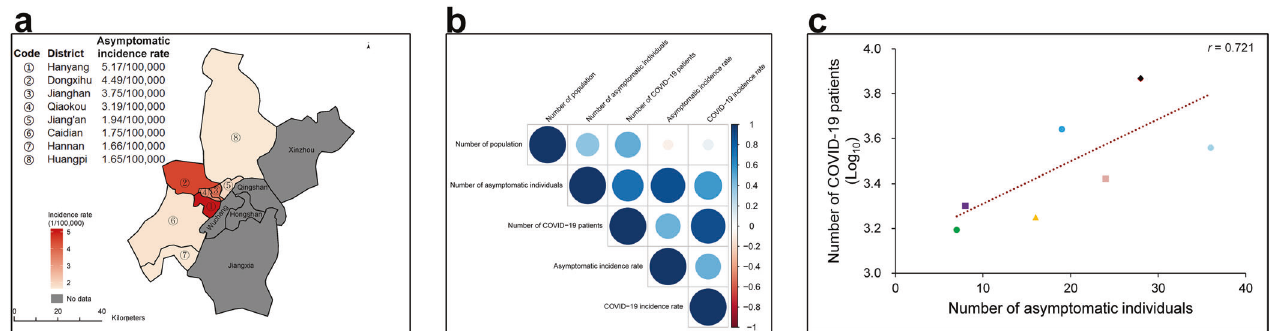
Fig. 1 The detection of asymptomatic individuals with SARS-CoV-2 infection and correlation with case number. a The incidence rates of asymptomatic patients in eight districts of Wuhan city; b Correlation matrix of asymptomatic individuals with total population and total COVID-19 patients. The number of COVID-19 patients was log10-transformed. The size and the color of each dot in the triangular matrix show the strength of Pearson correlation (positive or negative) between the variables. Positive strong correlations stand out in dark blue, lighter colors indicate weaker correlations; c The correlation of number of asymptomatic individuals with the number of COVID-19 patients (log10- transformed) in the eight districts of Wuhan city and the linear fi tting was performed. The different color and dots represent for the eight different districts of Wuhan city (green dot for Hannan District, purple dot for Caidian District, yellow dot for Huangpi District, light blue dot for Jiangan District, dark red dot for Dongxihu District, black dot for Jianghan District, light red dot for Qiaokou District and greyish blue dot for Hanyang District)